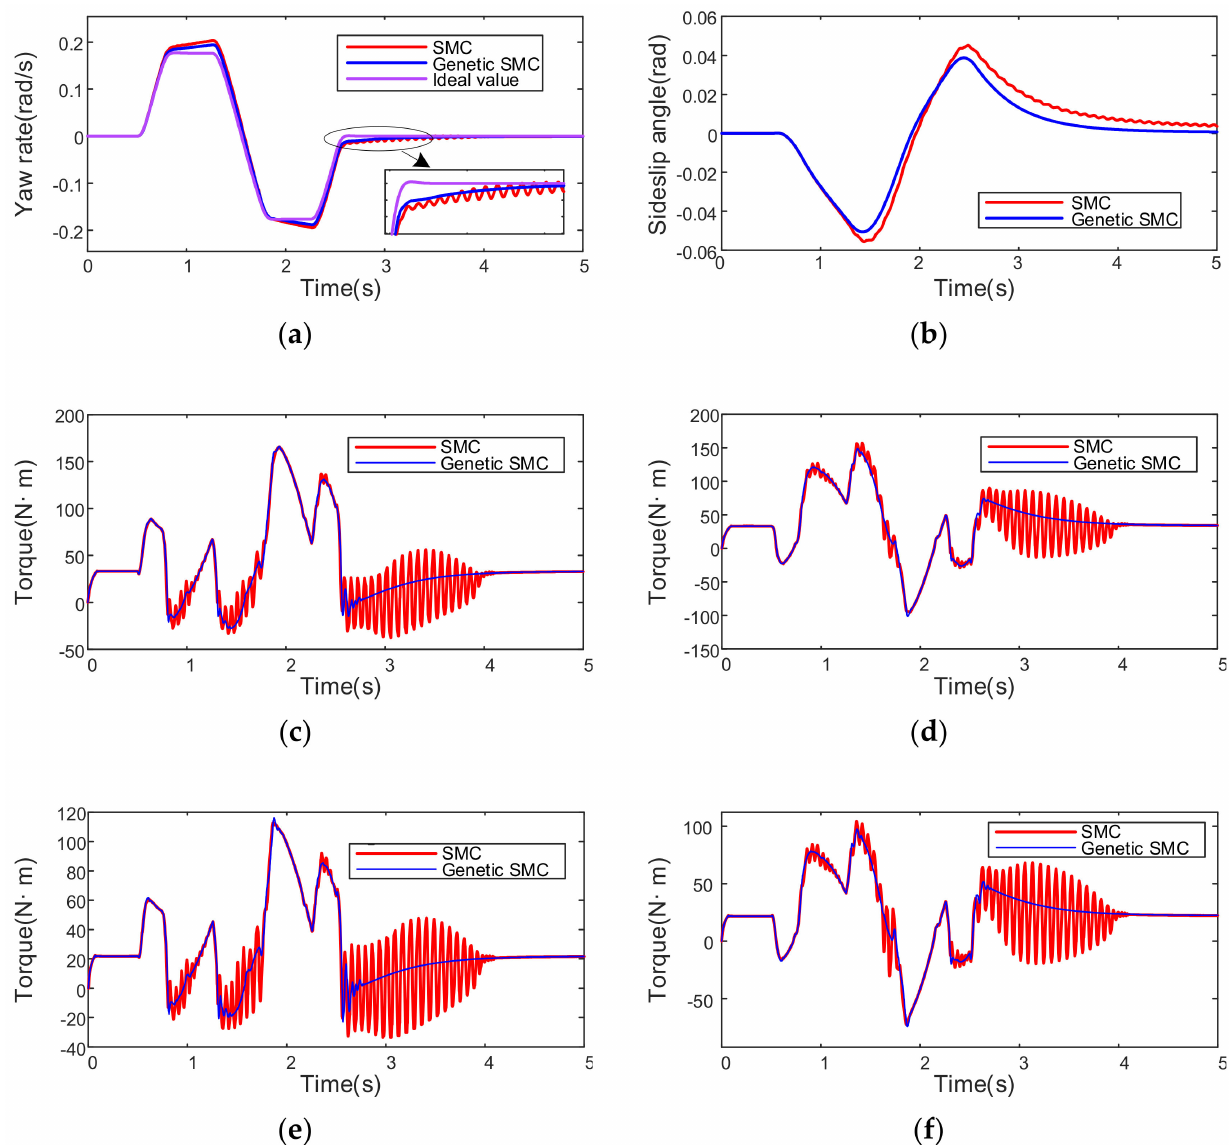
Figure 8. DYC controller on low tire–road friction coefficient road. ( a ) yaw rate; ( b ) sideslip angle; ( c ) front left driving torque; ( d ) front right driving torque; ( e ) rear left driving torque; and ( f ) rear right driving